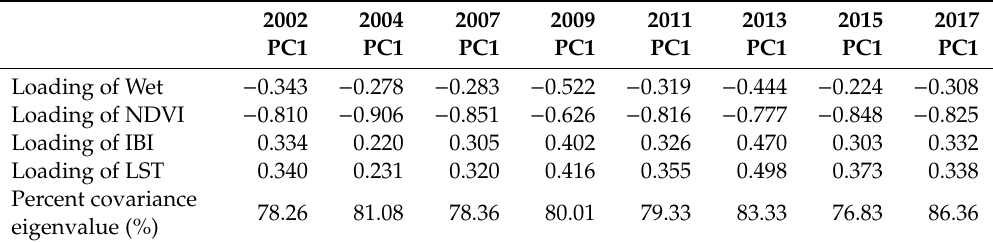
Table 1. Contributions / loadings of four variables to the first principal component (PC1).